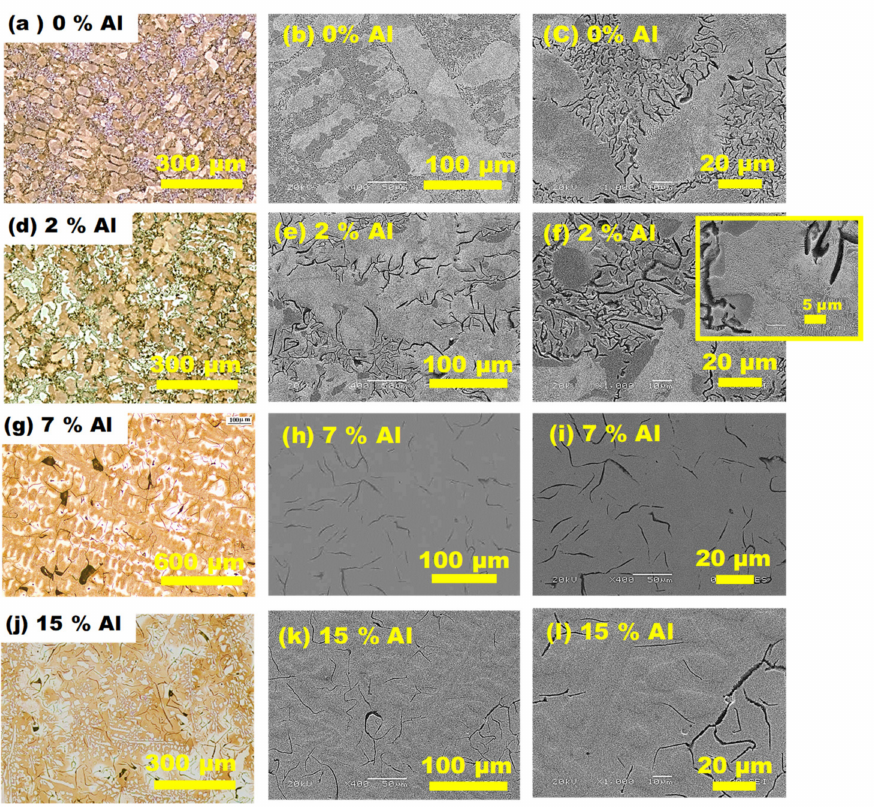
Figure 3. ( a – c ) Etched optical microscopy (OM) and SEM images of 0-Al; ( d – f ) etched OM and SEM images of 2-Al; ( g – i ); etched OM and SEM images of 7-Al and ( j – l ) etched OM and SEM images of 15-Al.